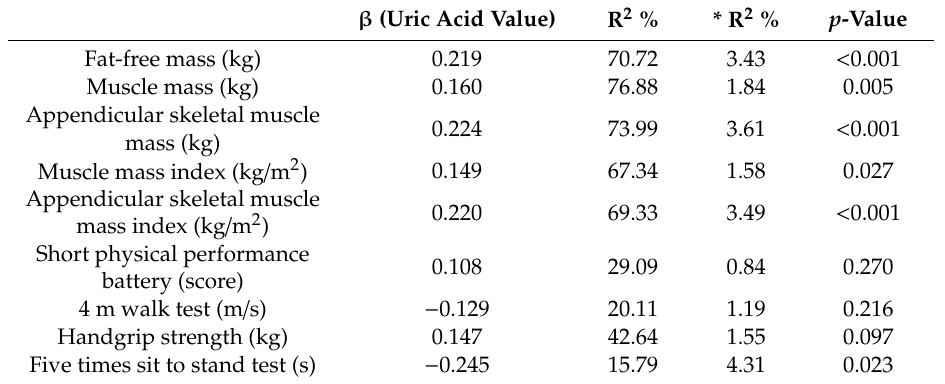
Table 2. Linear regression analysis of uric acid with muscle mass, strength and functional capacity. β (Uric Acid Value) R 2 % * R 2